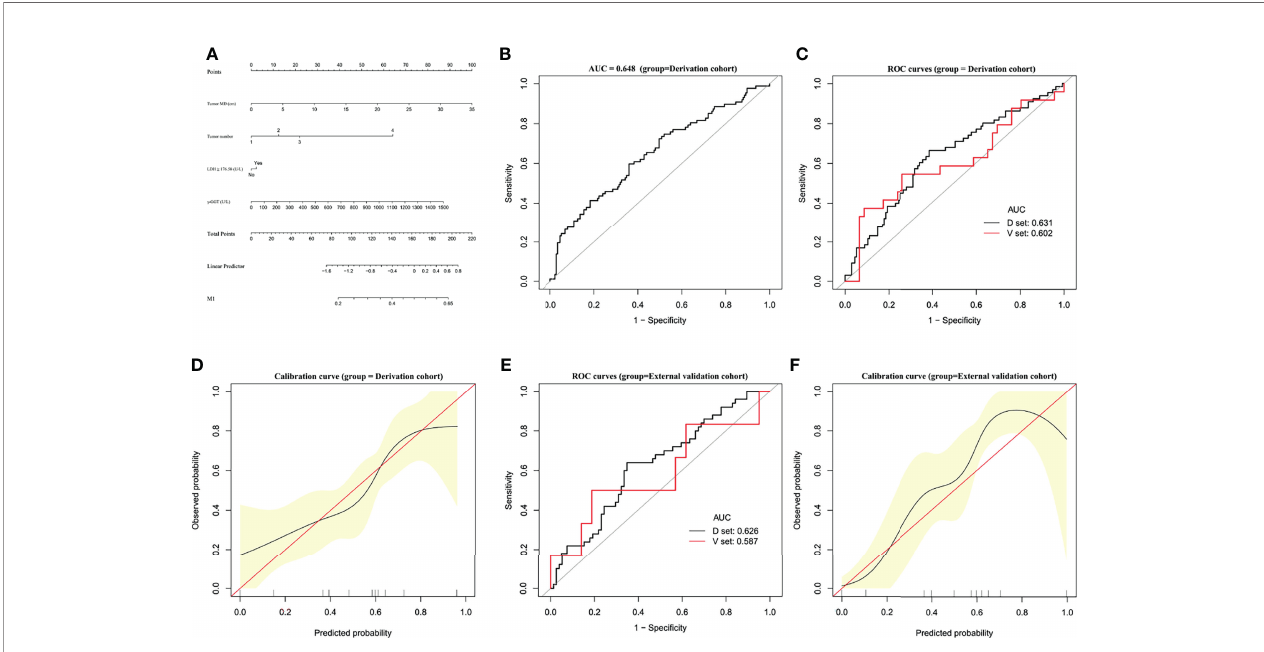
FIGURE 3 | Establishment and validation of M1 predictive nomogram for HCC patients . (A) M1 prediction scores were calculated with this four-factor nomogram by fi nding the position and corresponding y-axis point value of each variable and summing the point values of all fi ve variables, and then reading the probability on the x-axis. (B) M1 nomogram, AUC = 0.648 (95% CI 0.5773 – 0.7197). (C) Bootstrap analysis for internal validation and (D) GiViTI calibration plots showing good prediction- observation agreement for M1 in the derivation cohort. (E) Bootstrap analysis for internal validation and (F) GiViTI calibration plots showing good prediction-observation agreement for M1 in the external validation cohort. AUCs (shown in the fi gure and reported with 95% CI and c-index values in the text) indicate fair discrimination but with insuf fi cient separation, yielding poor discrimination. HL chi-square calibration values for each cohort are reported in the Results